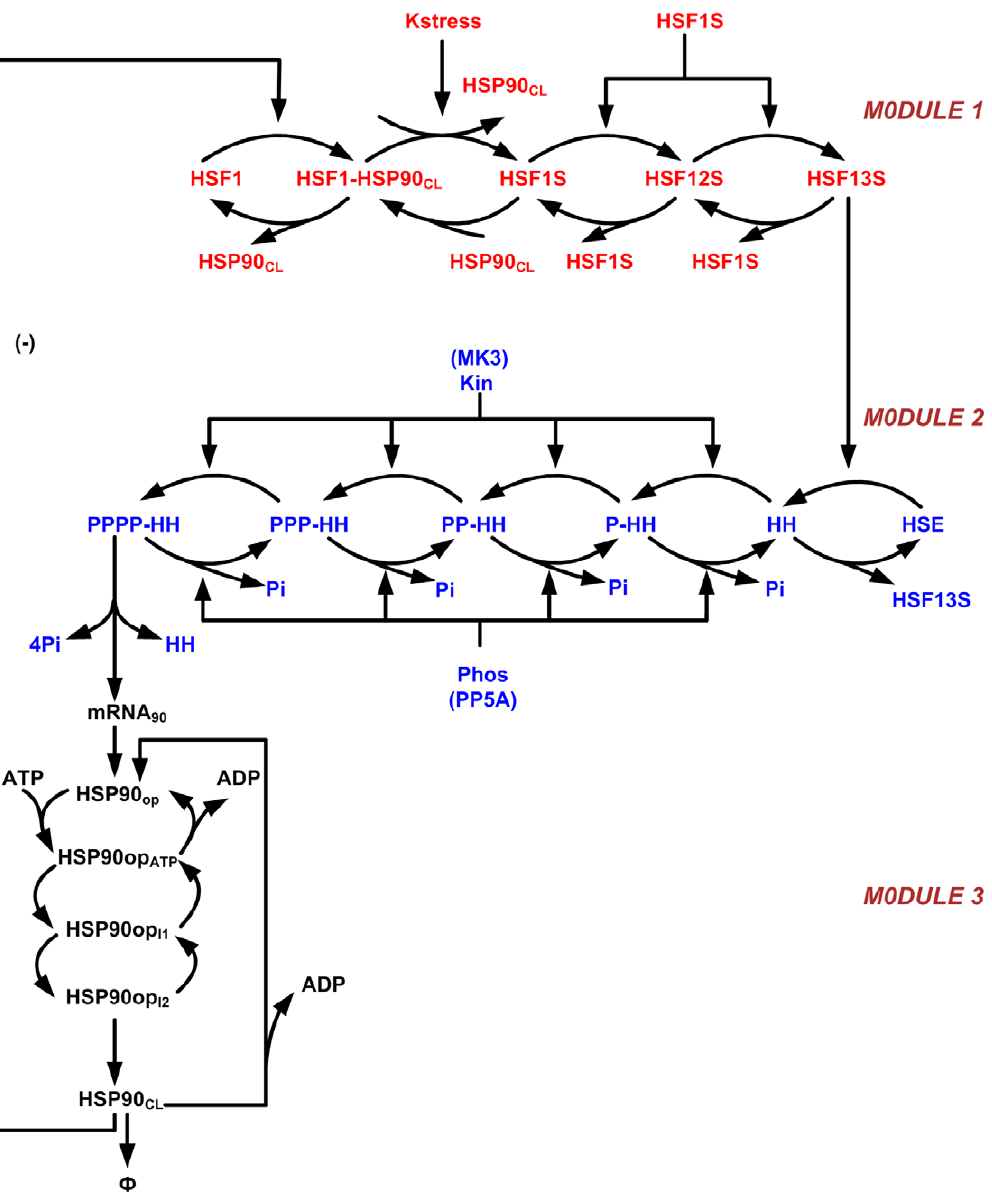
Figure 1. Modular construction of the heat-shock protein 90 (HSP90) network. Three modules form the whole network: HSF1 trimer formation, phosphorylation-dephosphorylation reactions of the HSP90:HSF1 trimer complex, and the conversion of an open to a closed HSP90 protein conformation. Module 1, shown in red, is the trimer formation of HSF1. Inactive HSF1 monomer sequestered by the closed conformation of HSP90 ( HSP90 CL ) forms a complex, HSF1 : HSP90 CL . Stress releases the inactive HSF1 monomer from the HSF1 : HSP90 CL complex, and turns it into an active form, HSF1S, to produce a dimer (HSF12S) slowly, but a trimer (HSF13S) rapidly. The trimer binds to the heat-shock element (HSE) to form a complex, HH, but it is incompetent to transcribe the hsp90 gene, unless strongly phosphorylated. Module 2, shown in blue, consists of the PdP reactions of the complex HH. The trimer HSF1S in the HH complex is hyper-phosphorylated by the kinase (MK3) and dephosphorylated by the phosphatase PP5, a co-chaperone. Hyper-phosphorylated HH ( HH pppp ) is competent to transcribe the hsp90 gene to produce mRNA 90 , which in turn translates into an open conformation of the HSP90 protein by series of steps. Module 3, shown in black, represents the formation of HSP90 closed conformation in which the open form of HSP90 op binds to adenosine triphosphate (ATP), and converts it to conformation HSP90 CL through two step wise intermediate conformations ( I 1,2 ). The fate of the closed form, which is competent to bind the substrate or the client proteins is three- fold: it (i) can shed the ATP to attain an open conformer, (ii) can bind to HSF1 monomer to negatively regulate its own production, finally (iii) can degrade to form a dead product, w .